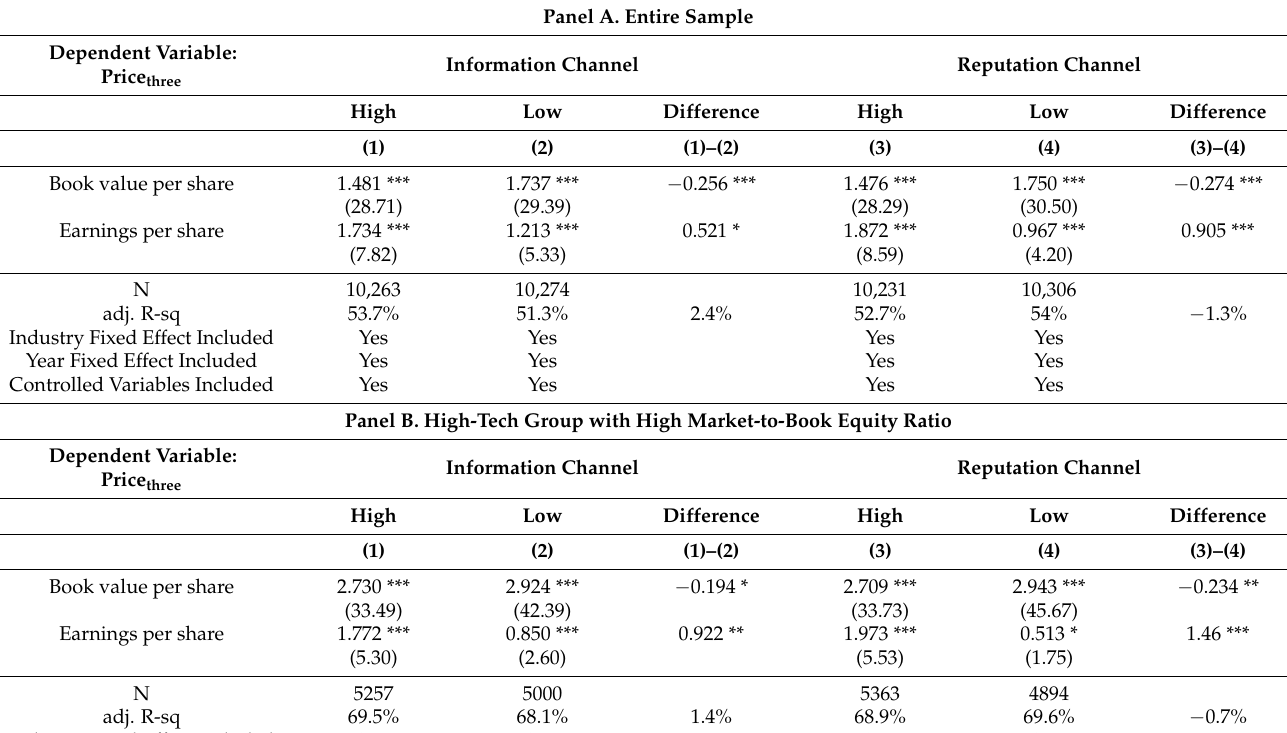
Table 10. Additional Analysis: Information Channel vs. Reputation Channel. This table presents the results of OLS regressions explaining the effect of CEO social capital on the value relevance of book value of equity and earnings metrics based on information and reputation channels. There are four panels in the table: Panel A presents the results for the entire sample; Panels B, C and D present the results for the high-tech group with high market-to-book equity ratio each year, with high research and development expenditures each year and within SIC codes defined by Francis and Schipper (1999) as high-tech related industries, respectively. In all panels, the dependent variable is Price three , a continuous variable measured by the market price of the common equity at the end of three months after fiscal year-end. CEO social capital is measured by Information Channel in columns (1) and (2) and Reputation Channel in columns (3) to (4). Variables of interest in the regression include Book value per share (book value of common equity scaled by number of shares outstanding) and Earnings per share (net income scaled by number of shares outstanding). All regressions include control variables as defined in Appendix A. For brevity, the table only presents coefficients related to the variables of interest. All regressions include time- and industry-fixed effects and the errors are robust to firm heteroscedasticity. T-values are reported in parentheses. Statistical significance of the coefficients is designated as ***, ** and * at 1%, 5% and 10% levels, respectively. Panel A. Entire